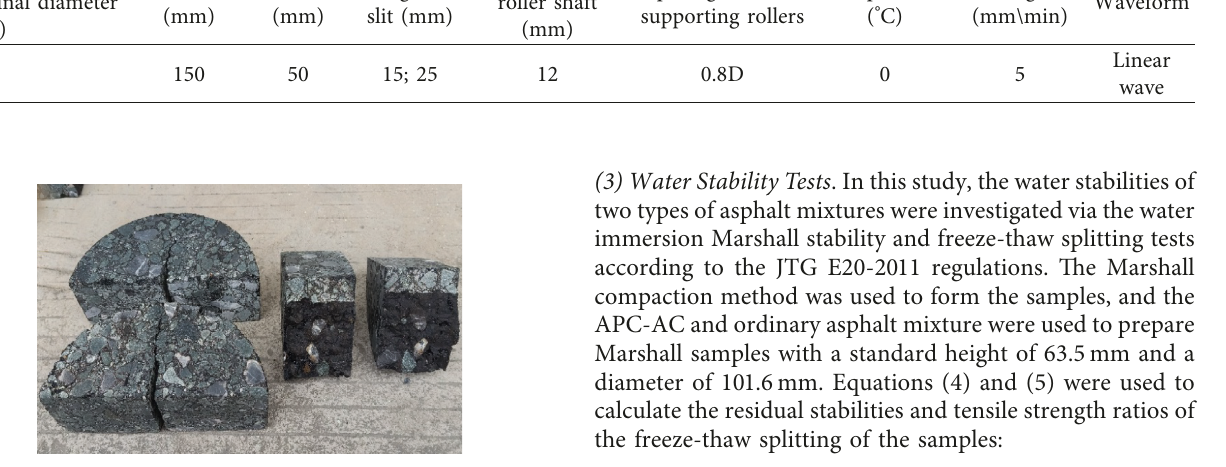
Figure 8: Photograph of the failed semicircular split samples.